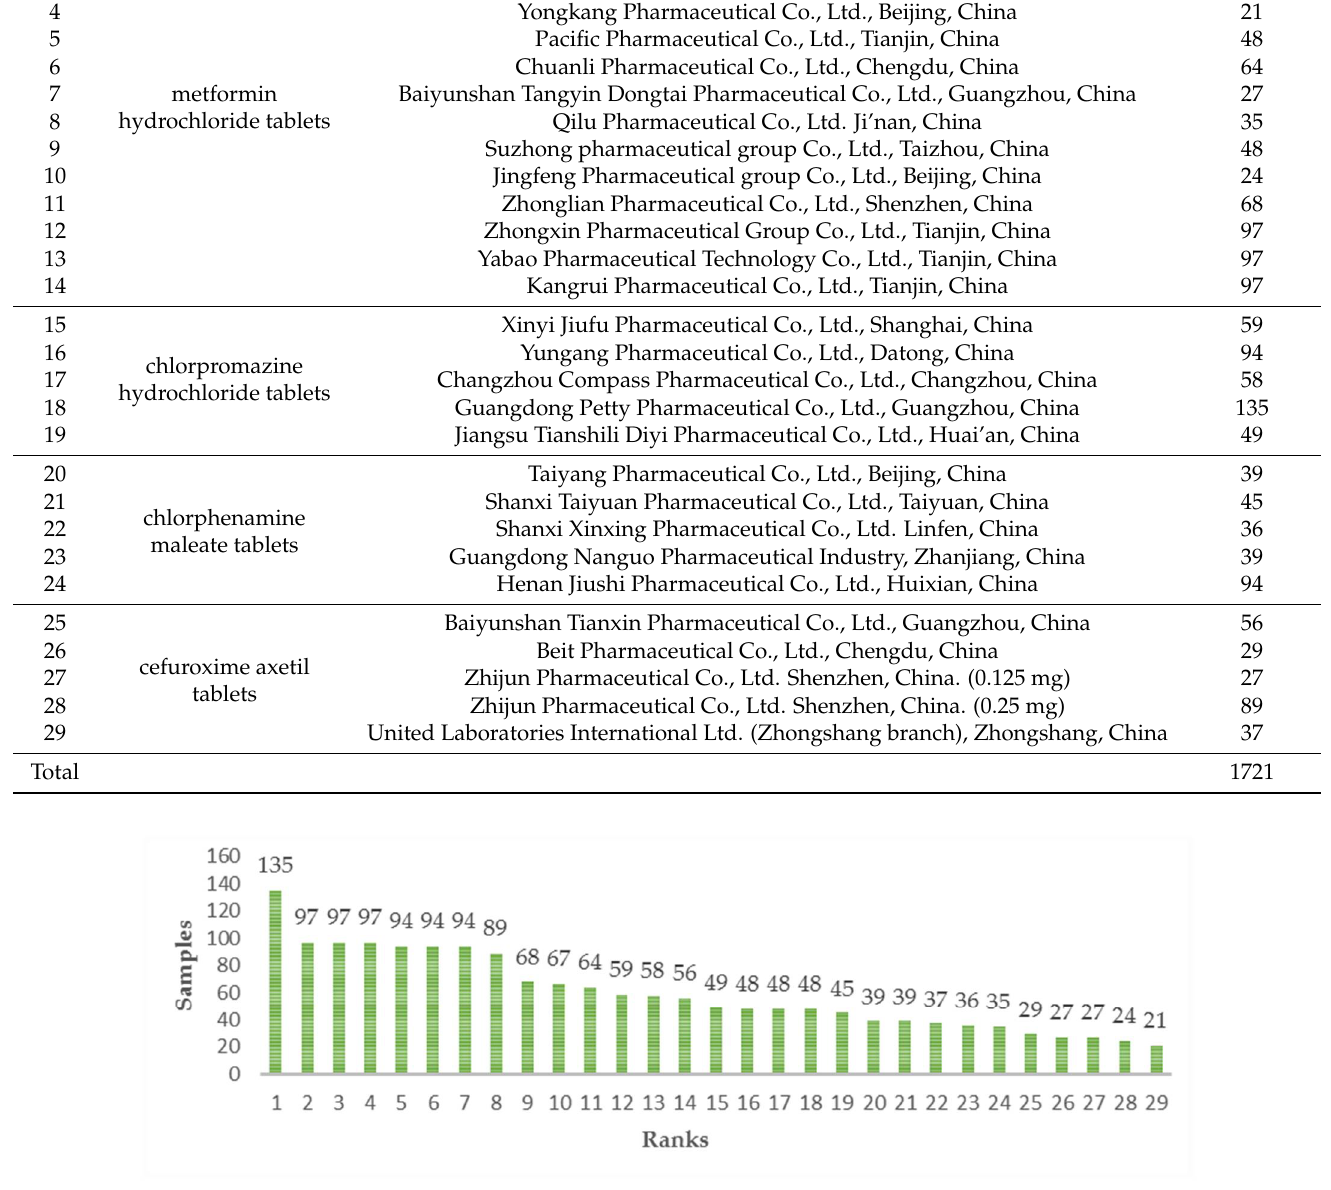
Figure 2. Intra-class samples are sorted from high to low. Every column stands for a class, the height value is the intra-class sample counts.